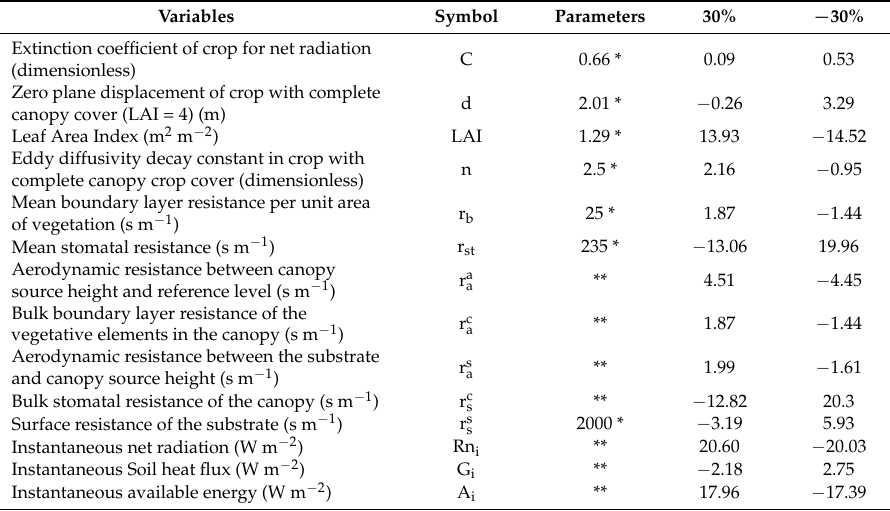
Table 4. Sensitivity analysis to instantaneous actual evapotranspiration (ET i